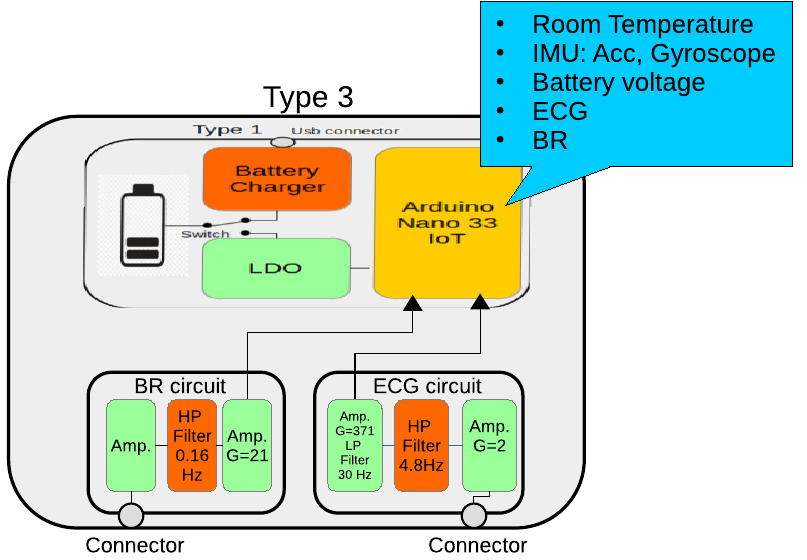
Figure 5. Block diagram of the the “Type 3” wearable. It contains ECG and BR